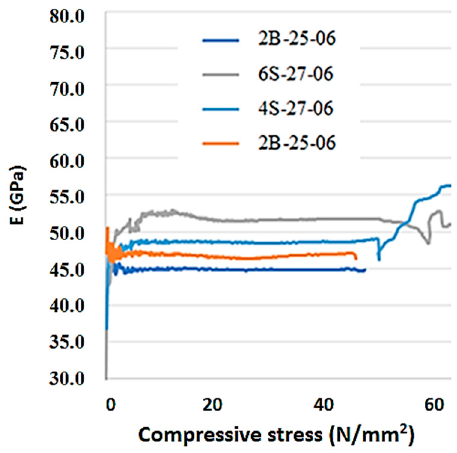
Figure 4. Load-modulus experimental curves.